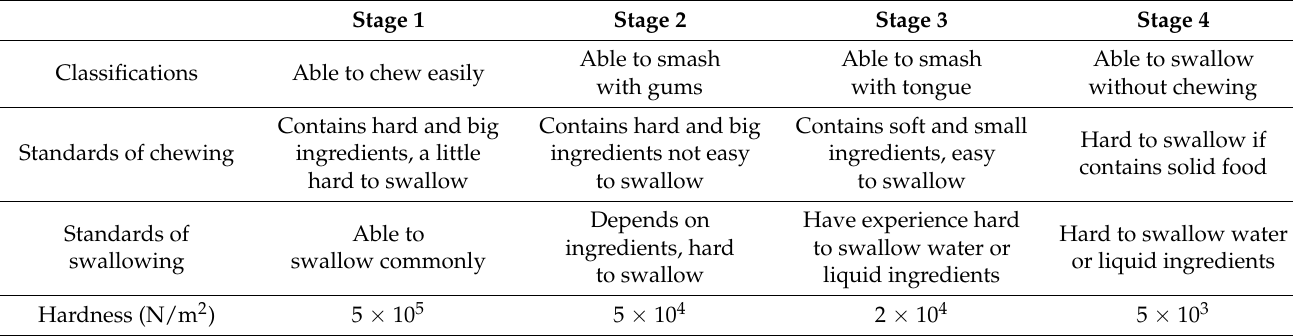
Table 1. The Universal Design Foods guidelines for elderly